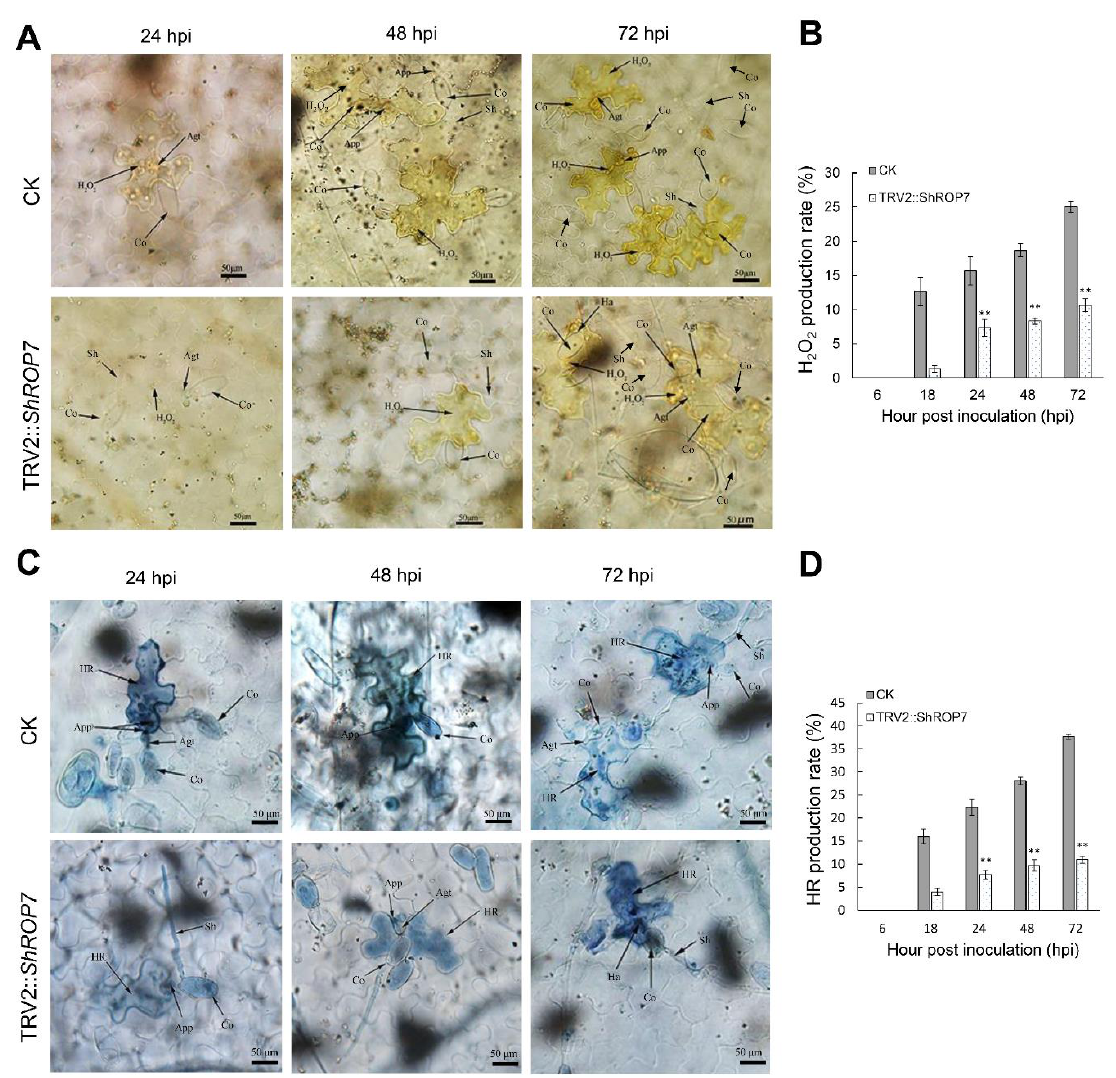
Figure 7. Silencing of ShROP7 reduced defense responses in tomato following powdery mildew infection. ( A ) Histological observation of H 2 O 2 accumulation in CK and ShROP7 -silenced plants inoculated with On -LZ at 24, 48 and 72 hpi in LA1777 plants. ( B ) The H 2 O 2 production rate was calculated at 6, 18, 24, 48 and 72 hpi. ( C ) Histological observation of hypersensitive cell death in TRV2 and ShROP7 -silenced plants inoculated with On -LZ at 24, 48 and 72 hpi in LA1777 plants. Blue (trypan) staining indicates hypersensitive cell death. ( D ) The HR production rate was calculated at 6, 18, 24, 48, and 72 hpi. Error bars represent the variations among three independent replicates. Asterisks ( ** ) indicates statistically significant differences between TRV2 and TRV2:: ShROP7 plants at each time point ( p < 0.01). Co, conidium; App, appressorium; Agt, appressorium germ tube; Sh, secondary hyphae; Ha, haustorium; Sa, secondary appressorium; HR, hypersensitive response. Bar, 50 μm.